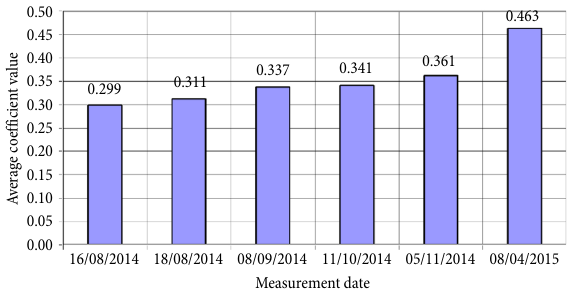
Measurement Fig. 10. Variation of average coefficient value for the experimental stretch over time